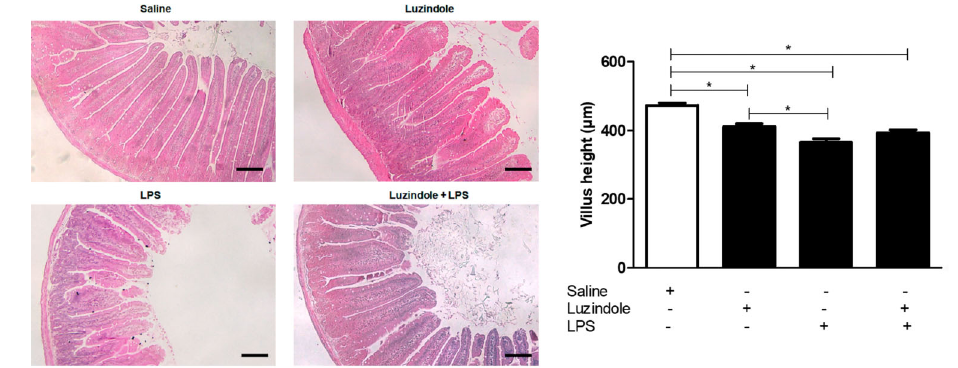
Figure 1. Representative histology of jejunal villus from the experimental groups treated with saline, Luzindole, lipopolysaccharide (LPS), and Luzindole + LPS. Scale bar=100 m m. Graph showing the villus height of each group. Data are reported as means ± SE. *P o 0.05 (ANOVA followed by Bonferroni ’ s